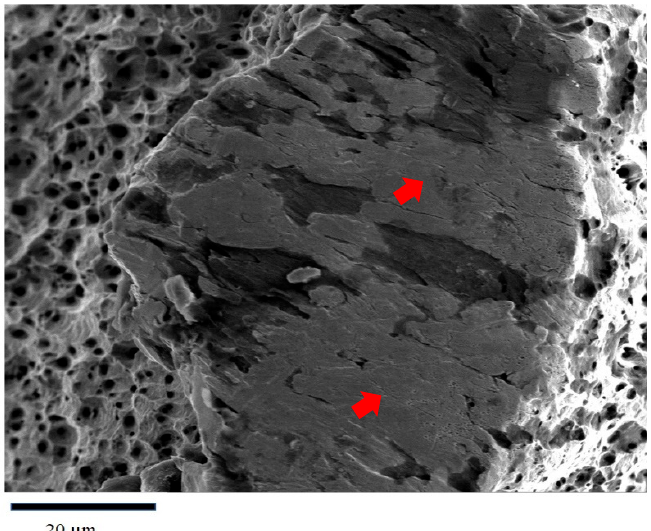
Figure 7. SEM fractography of 316 stainless steel samples tested in SWSSNC_Sil solutions at 60 °C. Arrows shows the features of SCC that were located in the areas adjacent to the sample edge.